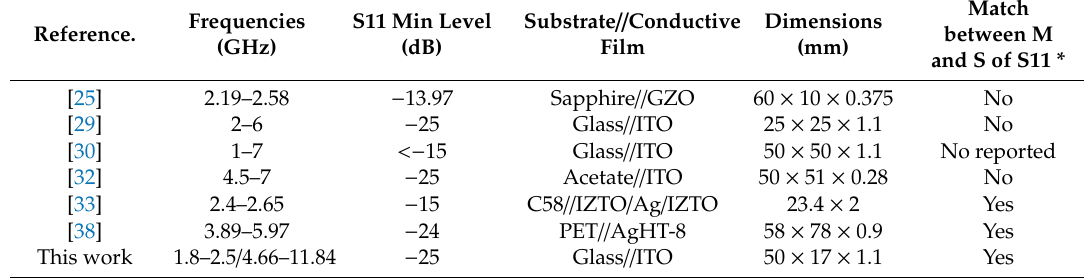
Table 5. Comparative Analysis with Other Transparent Antennas.